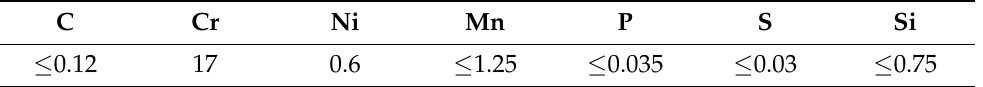
Figure 4. Sample cutting from slab casting for metallographic analysis.